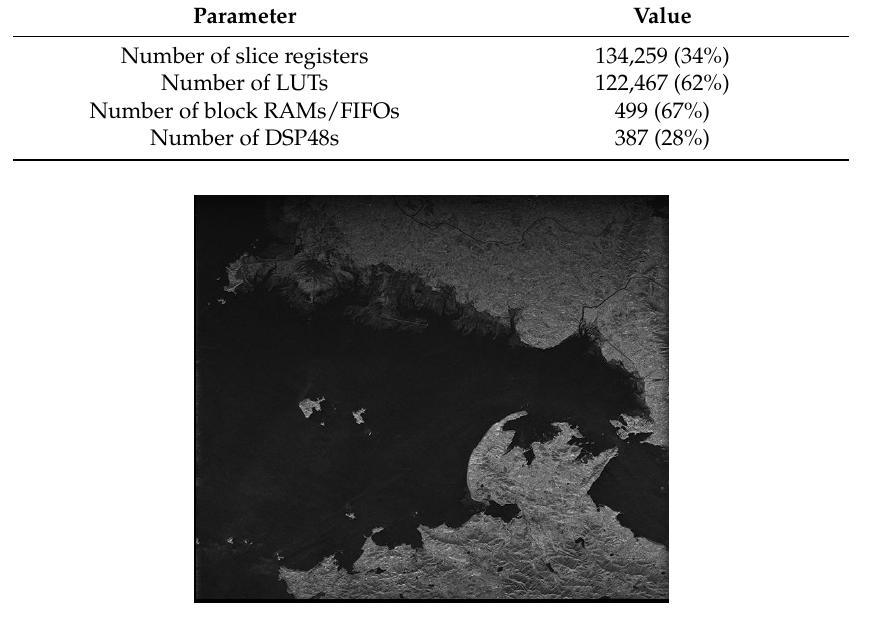
Figure 11. Actual scene imaging result of the system hardware. Table 6. Actual scene imaging quality assessment.